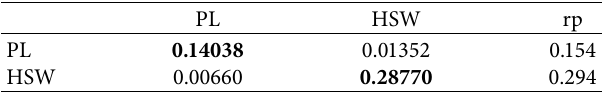
Table 7: Te phenotypic direct and indirect efects of diferent traits on grain yield.